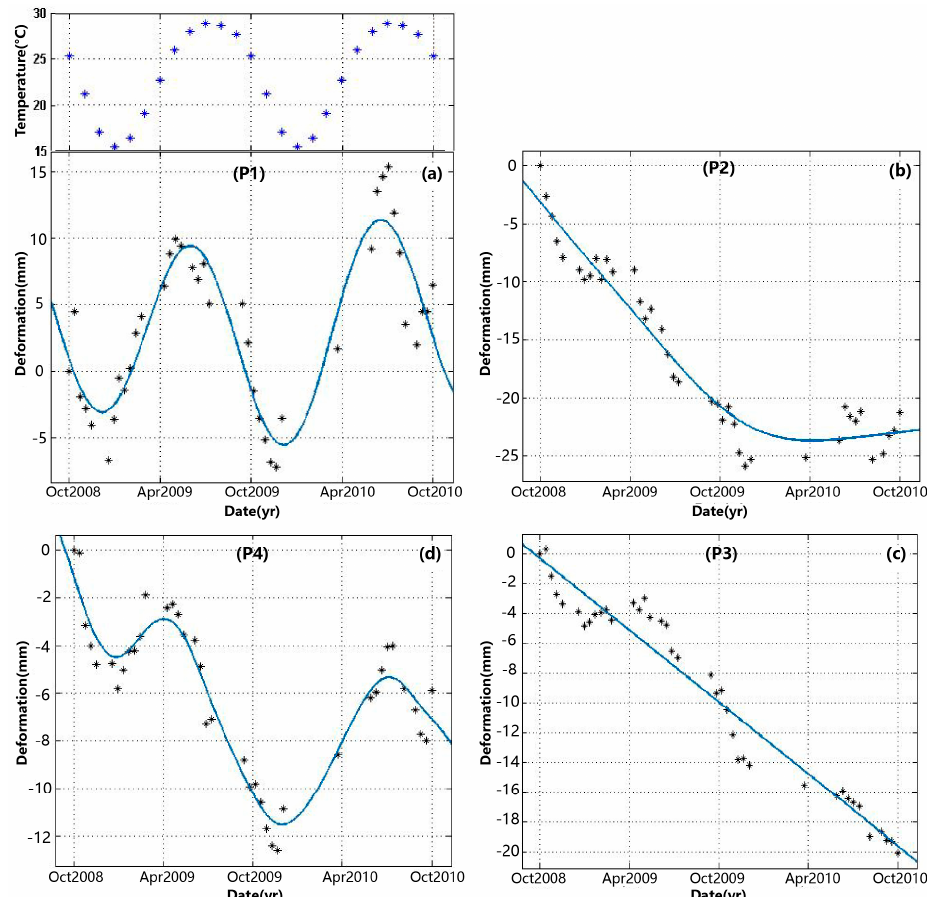
Figure 9. Deformation time series of four feature points in Figure 8. ( a – d ) The deformation time series of p1, p2, p3, and p4, respectively.